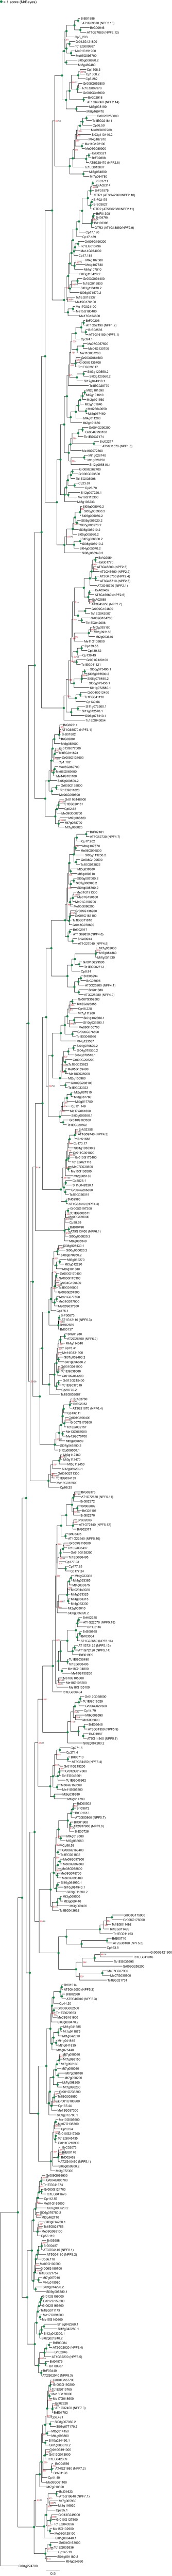
Phylogenetic relationships of NPF transporters from selected species.Bayesian inference (MrBayes) tree (s.d.< 0.01) of NPF transporters from selected species. Green circles at nodes represent a posterior probability of 1 (maximum is 1). Values at nodes separated by a backslash represent MrBayes values below 1 in red, followed by RAxML generated bootstrap values in black (only reported when Mrbayes value is below 1). Scale bar indicates number of substitutions per site.